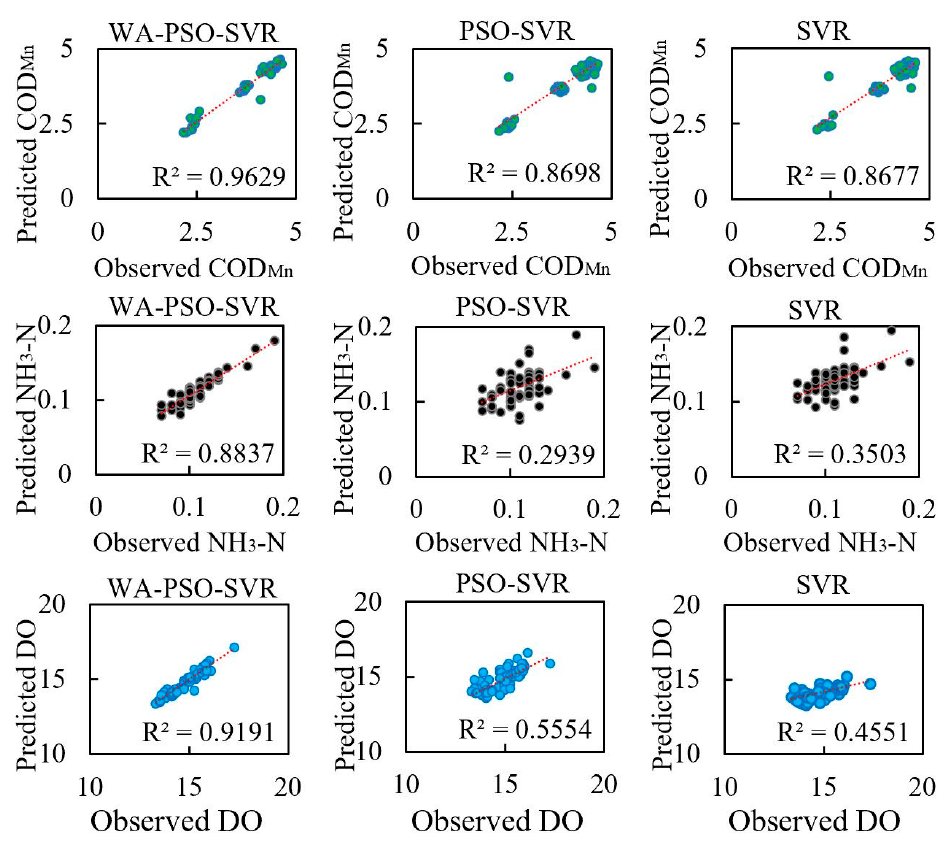
Figure 6. Scatter plots of predicted versus observed values (daily data) in the testing phase.